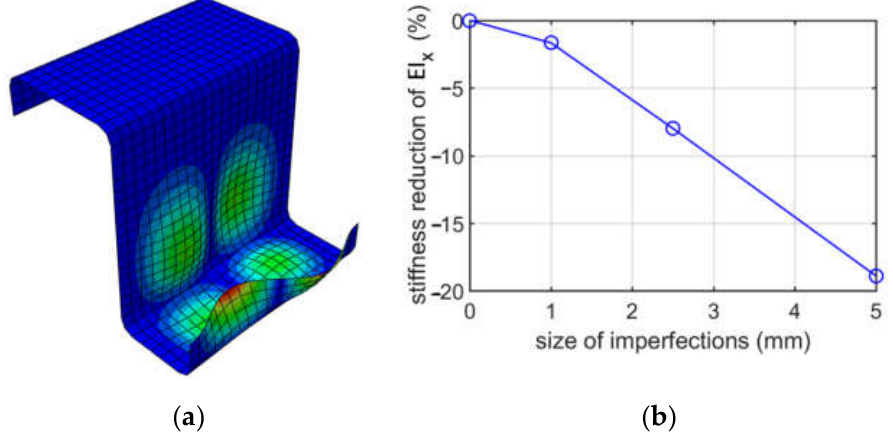
Figure 7. Buckling due to bending about the horizontal axis, top flange in tension ((i) case) for a depth of 100 mm: ( a ) mode 1; ( b ) plot of the stiffness reduction of EI x , depending on the size of imperfections. Table 3. Stiffness reduction of a Z profile with an elongation of 100 mm due to bending about the horizontal axis and tension of the lower part of the cross-section (case (ii)) is shown in horizontal axis for (i) case, depending on the size of imperfections. Figure 8. The plot of the reduction in the bending stiffness of EI x depending on the imperfection size is shown in Figure 4.